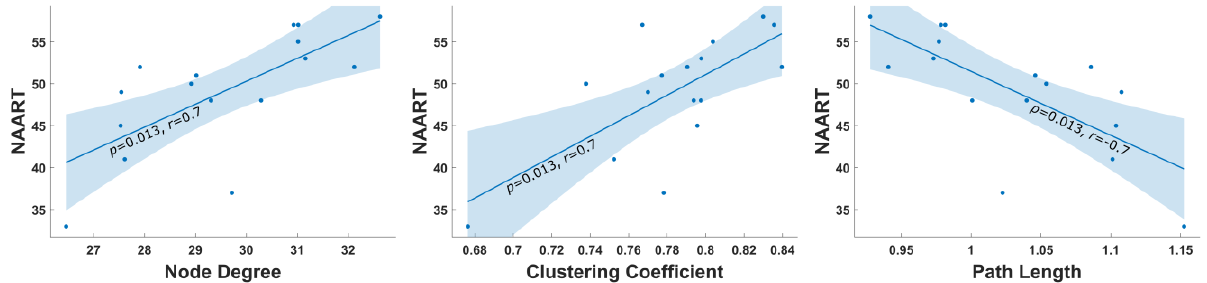
Figure 4. Linear regressions of H (2) network metrics and NAART scores . The indicated p -values are adjusted based on Benjamini – Hochberg correction.